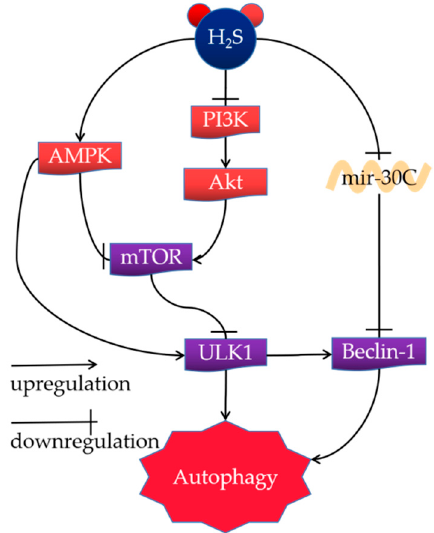
Figure 3. Mechanism of H 2 S regulation of autophagy in mammals.